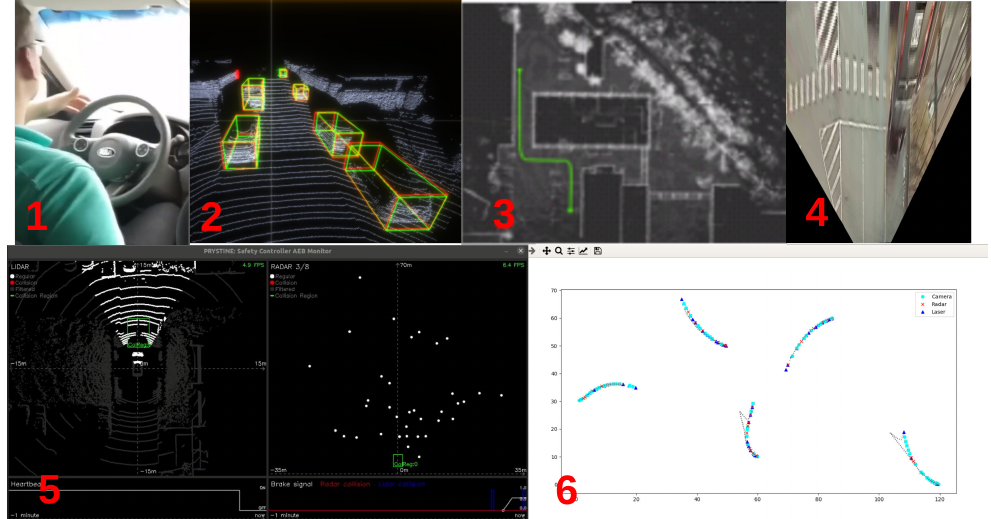
Figure 8. EDI DbW car perception: 1. Autonomous driving via DbW system; 2. Point cloud object recognition utilizing DNN capabilities; 3. LIDAR-based localization and path execution for operation in urbanized environments; 4. Camera-based inverse perspective mapping for object birds eye view tracking [33]; 5 and 6. Fail-operational object tracking and fusion involving RADAR, LIDAR, Camera